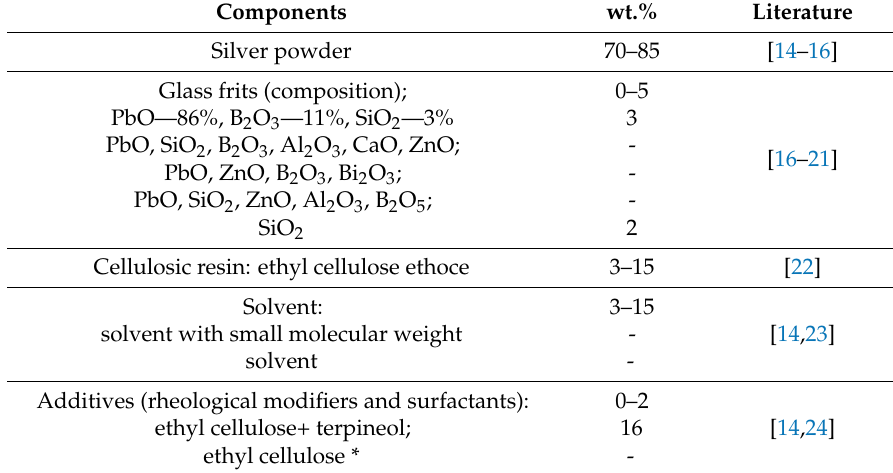
Table 1. Components of industrial deposited pastes